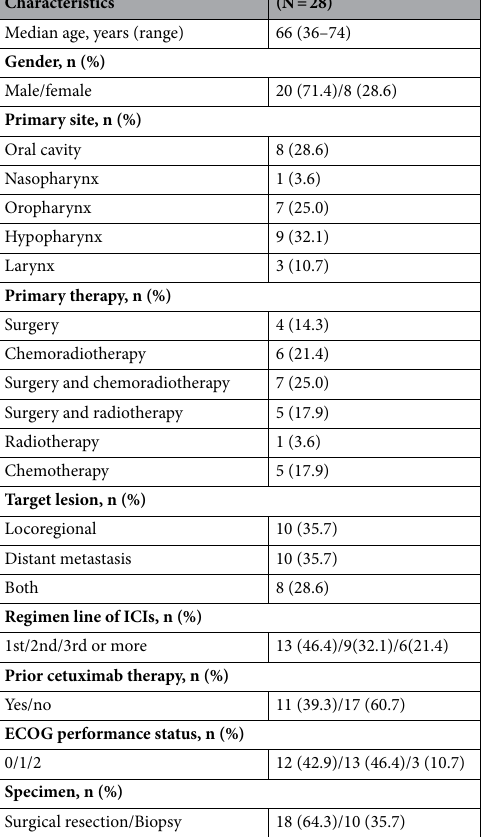
Table 1. Baseline characteristics of